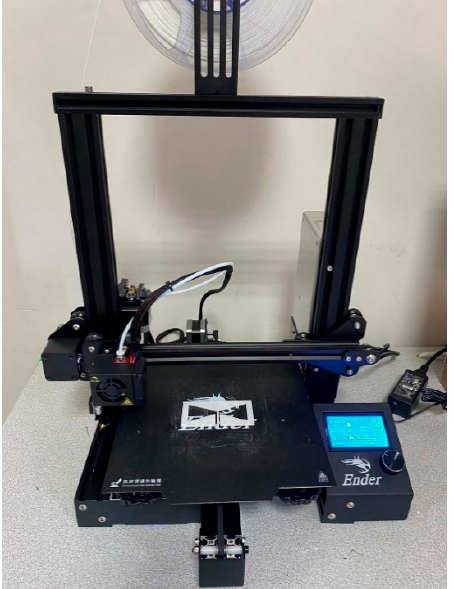
Figure 5. Creality Ender 3 Pro 3D printer.